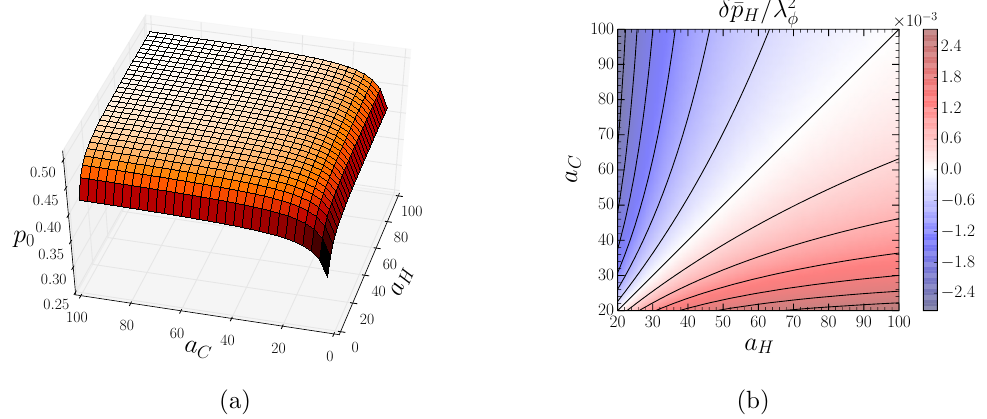
Figure 6. For v = 0 : 8 and the linearly coupled scalar interaction: at left, (a) exhibits the nature of the critical probability for completing the thermodynamic cycle, and at right (b) plots the correction (cid:14) (cid:22) p H as a function of the critical probability. Red regions show where we get positive work and blue